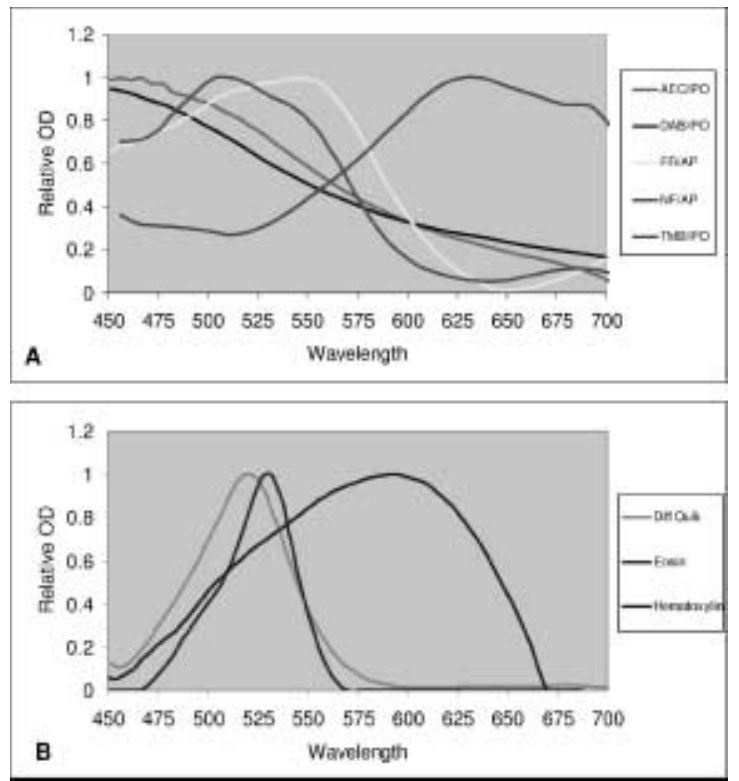
Fig. 1. Chart of pure dye absorption spectra used in ISH and ICC experiments expressed in relative optical density (OD) for all wavelengths between 450 and 700 nm of (A) enzyme precipitates, and (B)